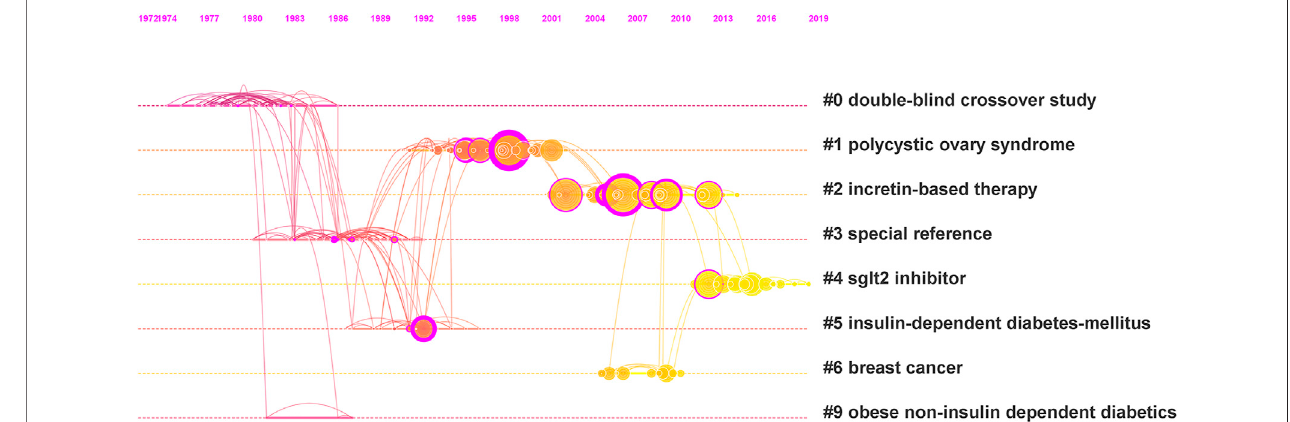
FIGURE 7 | Visualized timeline of co-citation clusters in metformin research area.